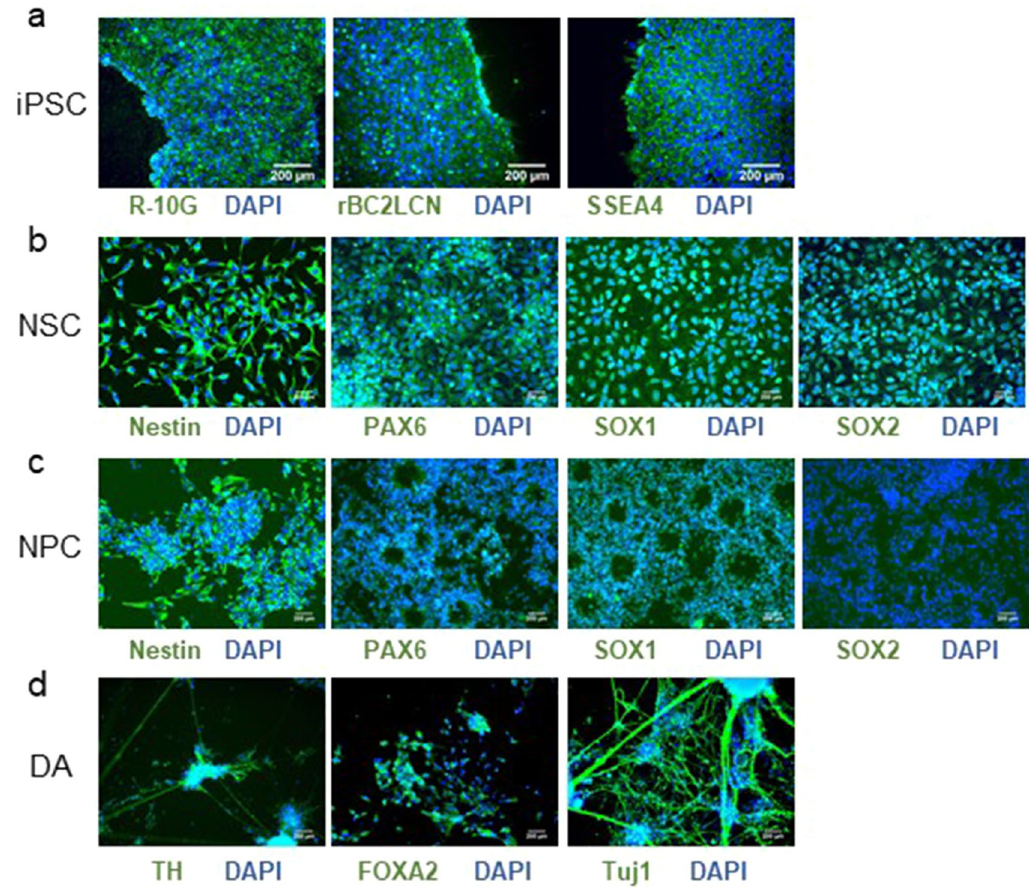
Figure 2. Immunofluorescence assays using antibodies against differentiation marker proteins. ( a ) R-10G (left panel), rBC2LCN (middle panel), and SSEA4 (right panel) in the membrane of the iPS cells. ( b ) Nestin (left) in the cytoplasm, PAX6 (second left) in the nucleus, SOX1 (second right) in the nucleus, and SOX2 (right) in the nucleus of the iPSC-derived neural stem cells. ( c ) Nestin (left) in the cytoplasm, PAX6 (second left) in the nucleus, SOX1 (second right) in the nucleus, SOX2 (right) in the nucleus in the iPSC-derived neural progenitor cells. ( d ) Tyrosine hydroxylase (left) in the cytoplasm, FOX2 (middle) in the nucleus, and Tuj1 (right) in